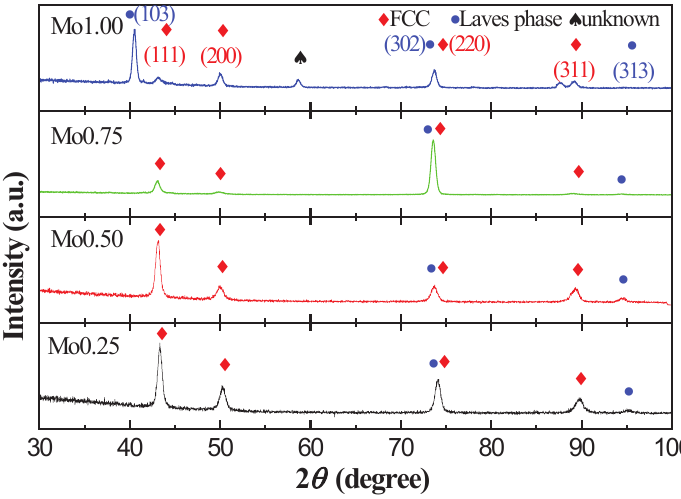
Figure 1. XRD patterns of CoFeNiMnMo x ( x = 0.25, 0.5, 0.75 and 1.0) alloys.